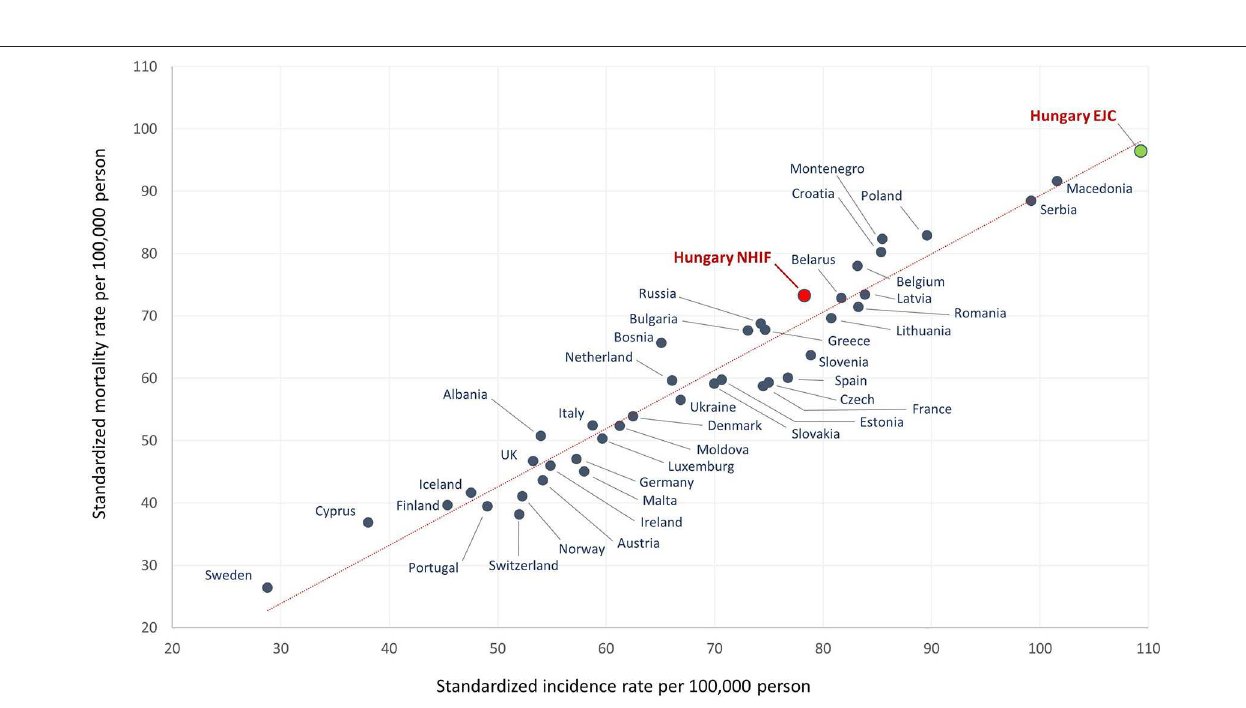
2. The age-standardized incidence of lung cancer